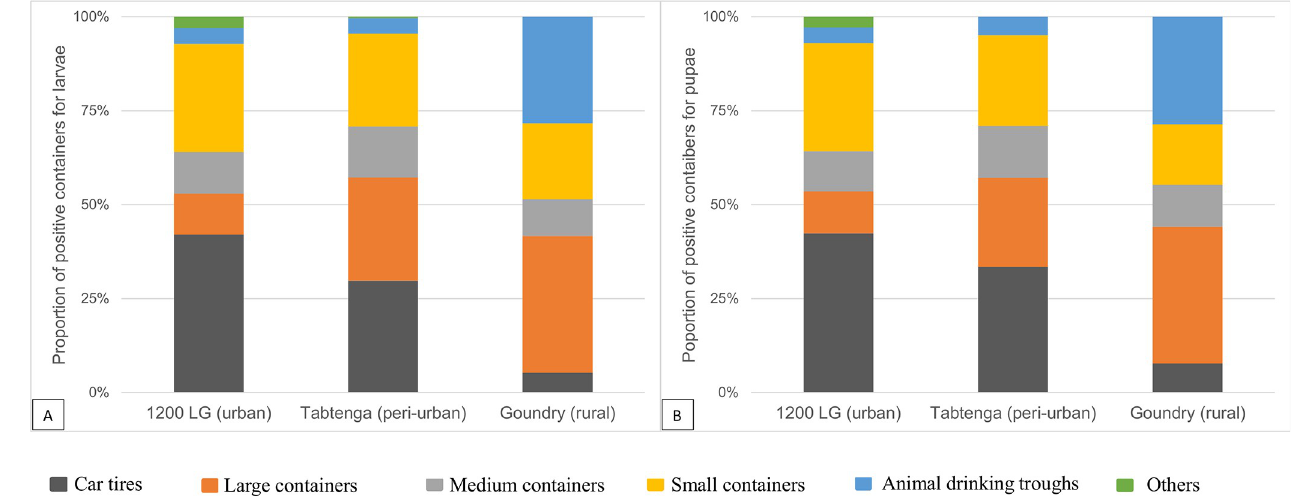
Fig 2. Distribution of all larvae (Fig 2A) and pupae (Fig 2B) across the different positive container types.